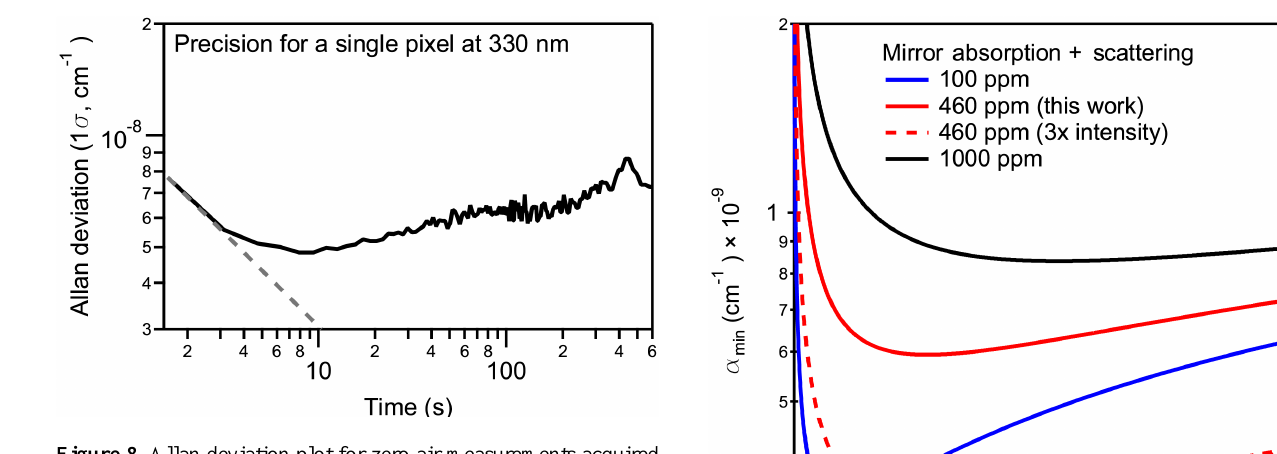
Figure 8. Allan deviation plot for zero air measurements acquired by the BBCEAS instrument, showing the relationship between av- eraging time and 1 σ precision for a single pixel at 330nm. The dashed line shows the relationship expected for statistically random noise.